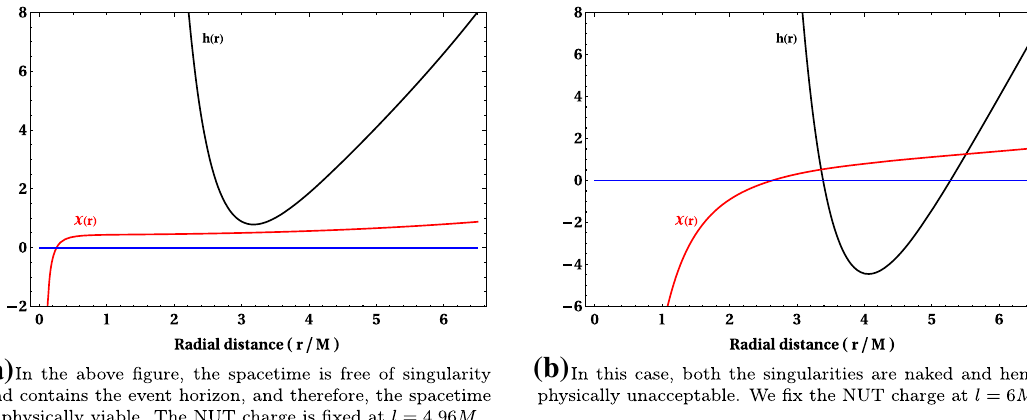
Fig. 5 The above figures illustrate the two examples with λ > 36, where we fix the cosmological constant (cid:2) M 4 = 0 . 06